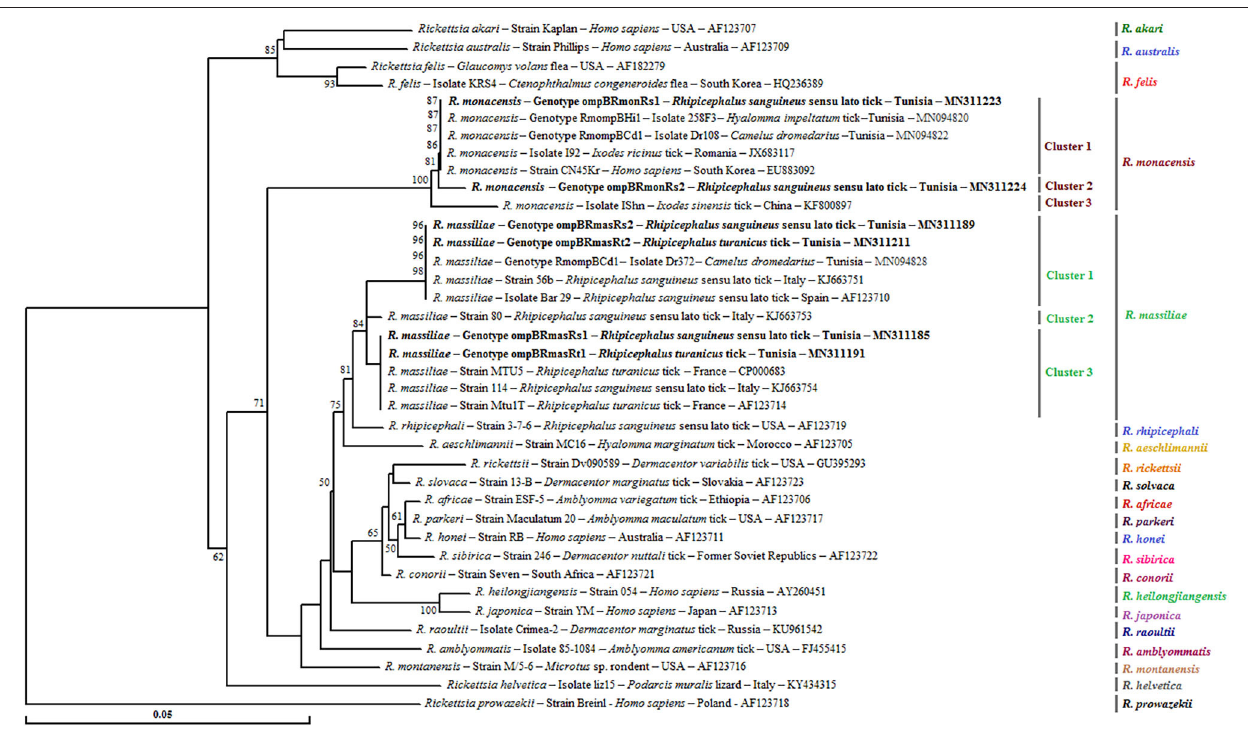
FIGURE 2 | Neighbor-joining tree based on the alignment of partial ompB sequences (382 bp) of Rickettsia spp. obtained in this study with selected sequences representative of the Rickettsia genus. Numbers over the branches indicate the percentage of replicated trees in which the associated taxa clustered together in the bootstrap test (1,000 replicates, only percentages > 50% were represented). The six partial ompB sequences representative of different Rickettsia spp. genotypes obtained in this study are indicated in bold. The host or vector, the genotype, strain or isolate name, the country of origin, and the GenBank accession number are indicated. One R. prowazekii ompB partial sequence was added as an